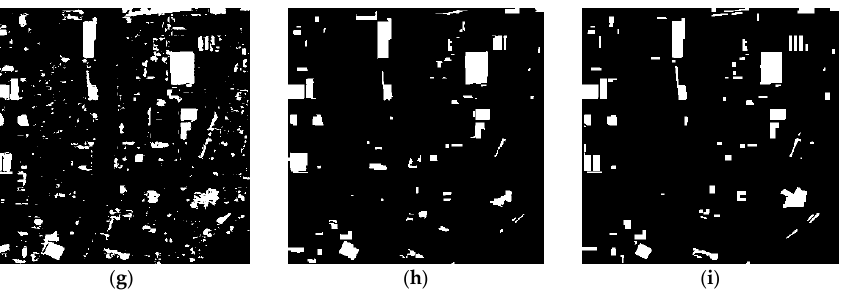
Figure 8. Change detection maps obtained on the first location by: ( a ) Extreme Learning Machine ELM, ( b ) Support Vector Machine (SVM), ( c ) Multiple Linear Regression (MLR), ( d ) Artificial Neural Network (ANN), ( e ) Deep Convolutional Neural Network (DCNN) ( ω = 7), ( f ) Traditional Siamese Convolutional Neural Network (TSCNN) ( ω = 7), ( g ) Deep Siamese Multi-Scale Convolutional Network (DSMS-CN) ( ω = 7), ( h ) Deep Siamese Convolutional Network based on Convolutional Feature Extraction Module (OB-DSCNH) ( ω = 7, l =40), ( i ) Reference map.